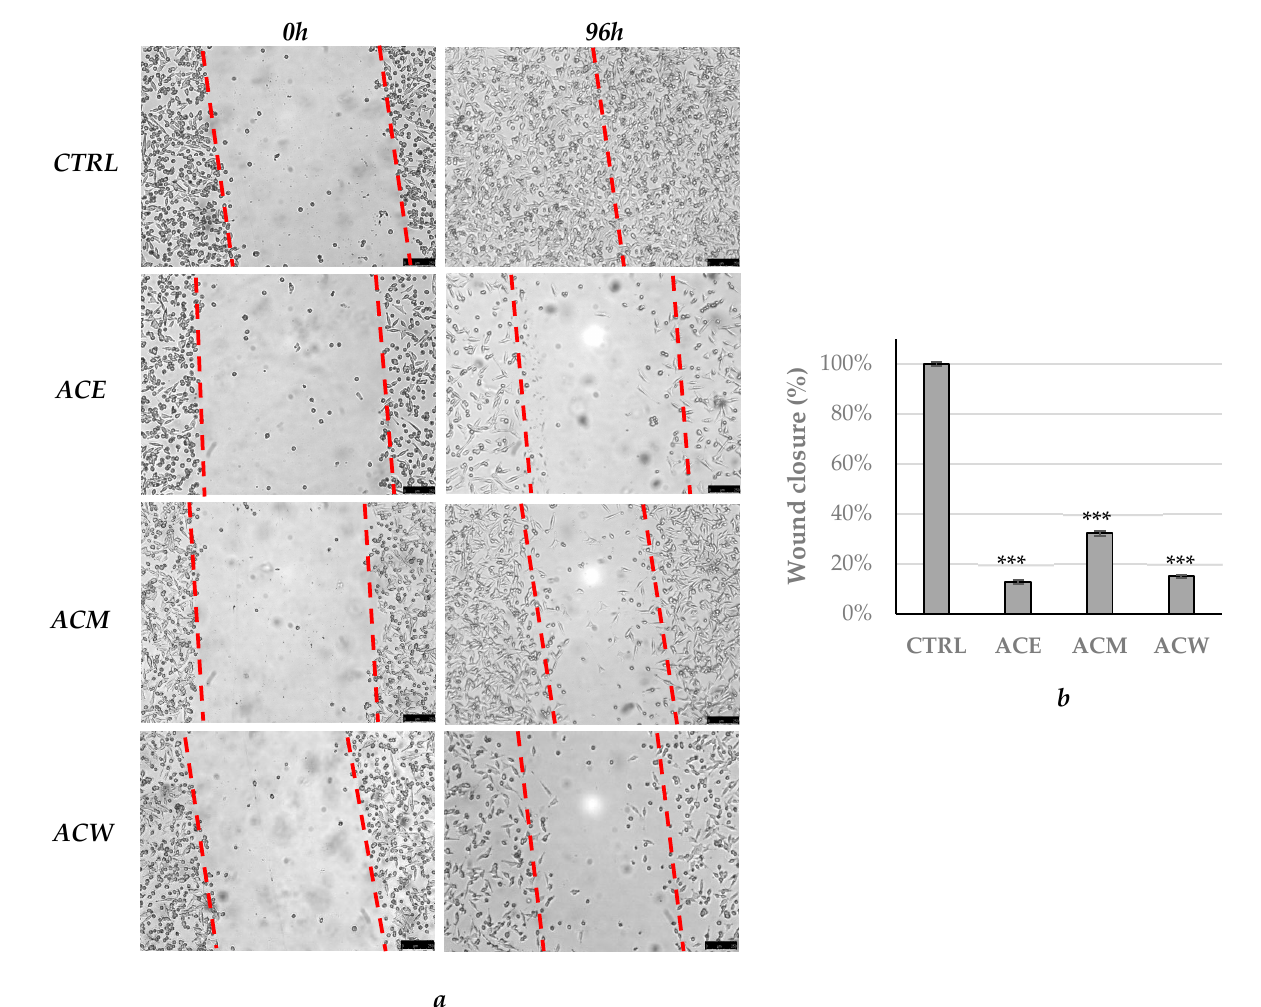
Figure 4. ( a ) Wound-healing assay conducted on A2058 cells treated with ethanolic, methanolic and aqueous A. cherimola Mill. leaf extracts (ACE, ACM and ACW) at their IC 50 values or with vehicle (DMSO, CTRL). Wound closure was monitored at 0 and 96 h using an inverted microscope (5 × magnification). Dotted red lines define the areas that lack cells. ( b ) The percentage of wound closure was calculated using ImageJ, as reported in Materials and Methods, in order to estimate the wound-healing effect. *** p < 0.001, ACE, ACM and ACW vs. CTRL.